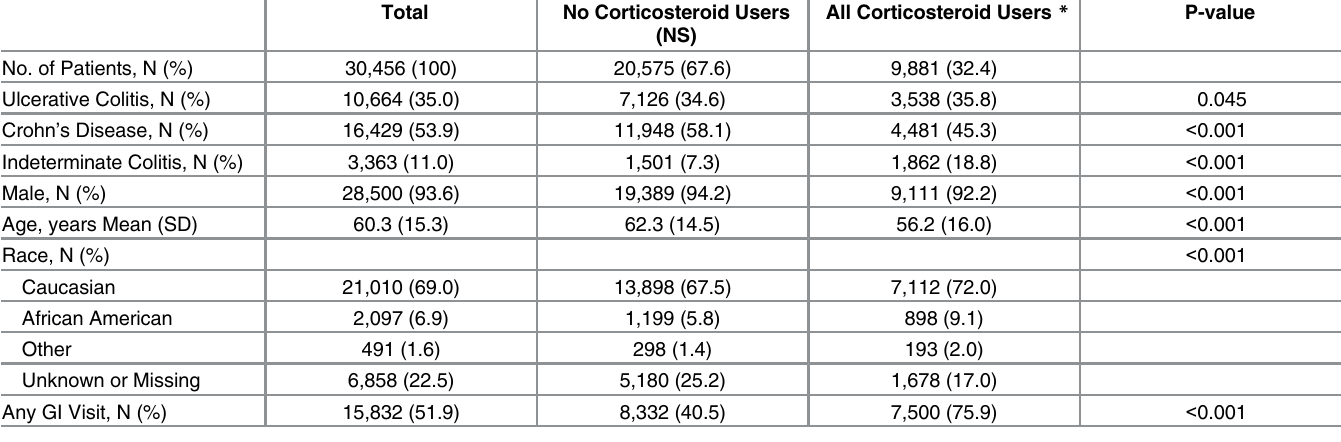
Table 1. Patient Characteristics of no corticosteroid and all corticosteroid users among IBD Veterans. Total No Corticosteroid Users All Corticosteroid Users * (NS)